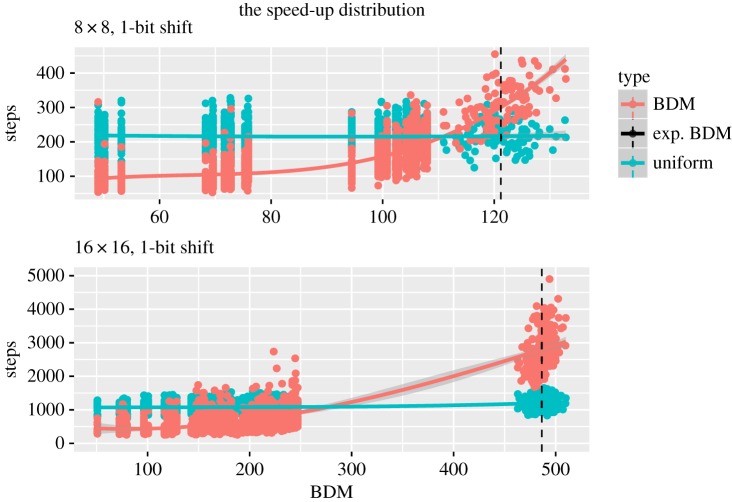
The positive speed-up instances are those where the coral curve, computed as a cubic linear regression to all the evolution times for the BDM strategy, are below the teal line, which is a cubic approximation to the evolution times for the uniform strategy. The black line is the expected BDM value for a randomly chosen matrix. The large gap in the data reflects the fact that it is hard to find structured (non-random) objects.